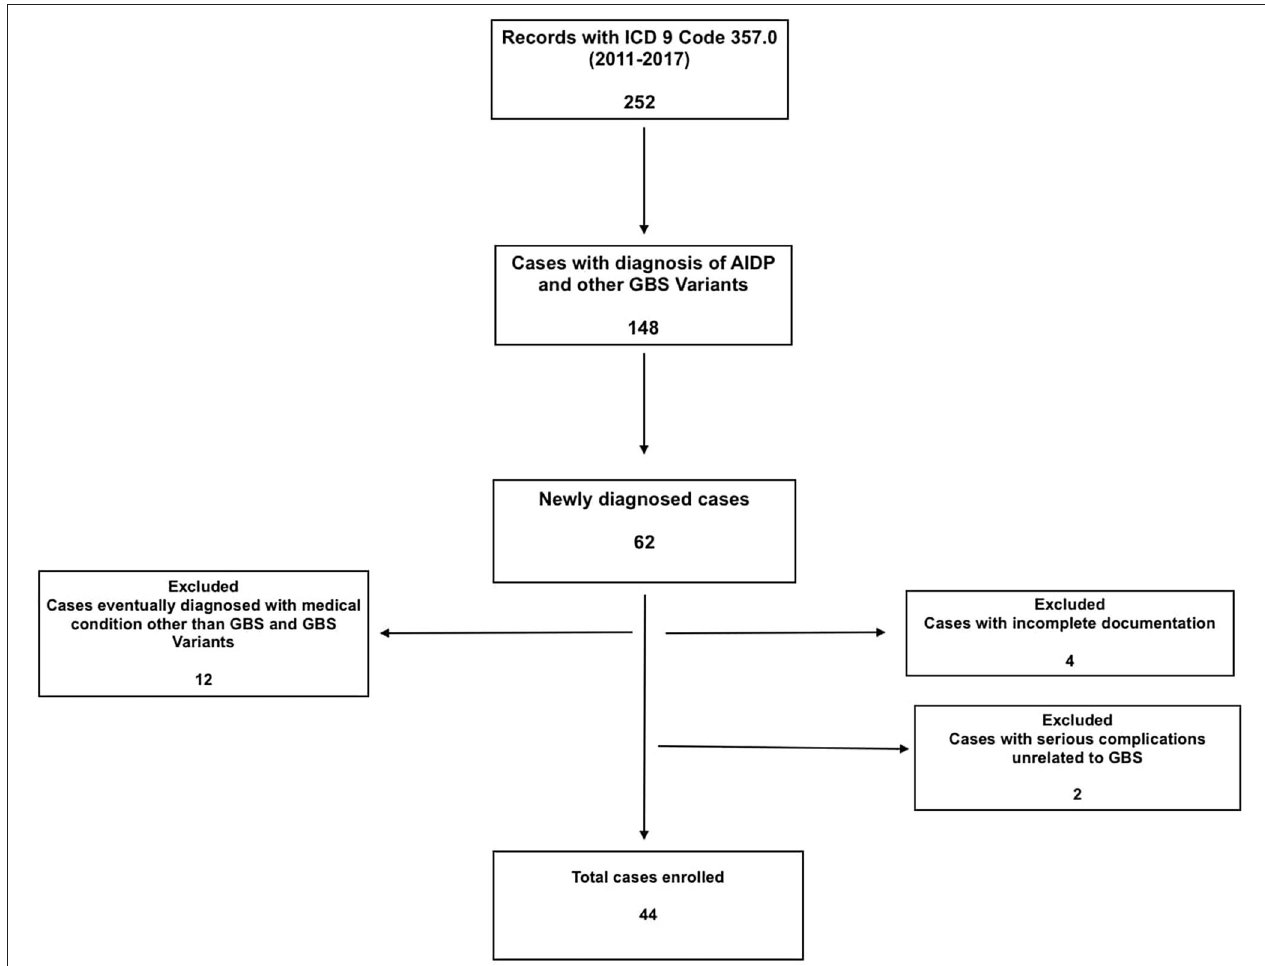
FIGURE 1 | Consort diagram for patient